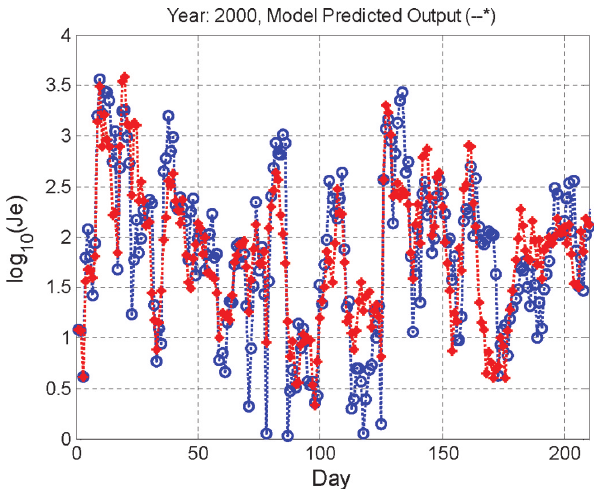
Fig. 4. A comparison between model predicted outputs and the corresponding measurements during a period in year 2000. Note that the model was generated from the initial full model with time lags up to m =